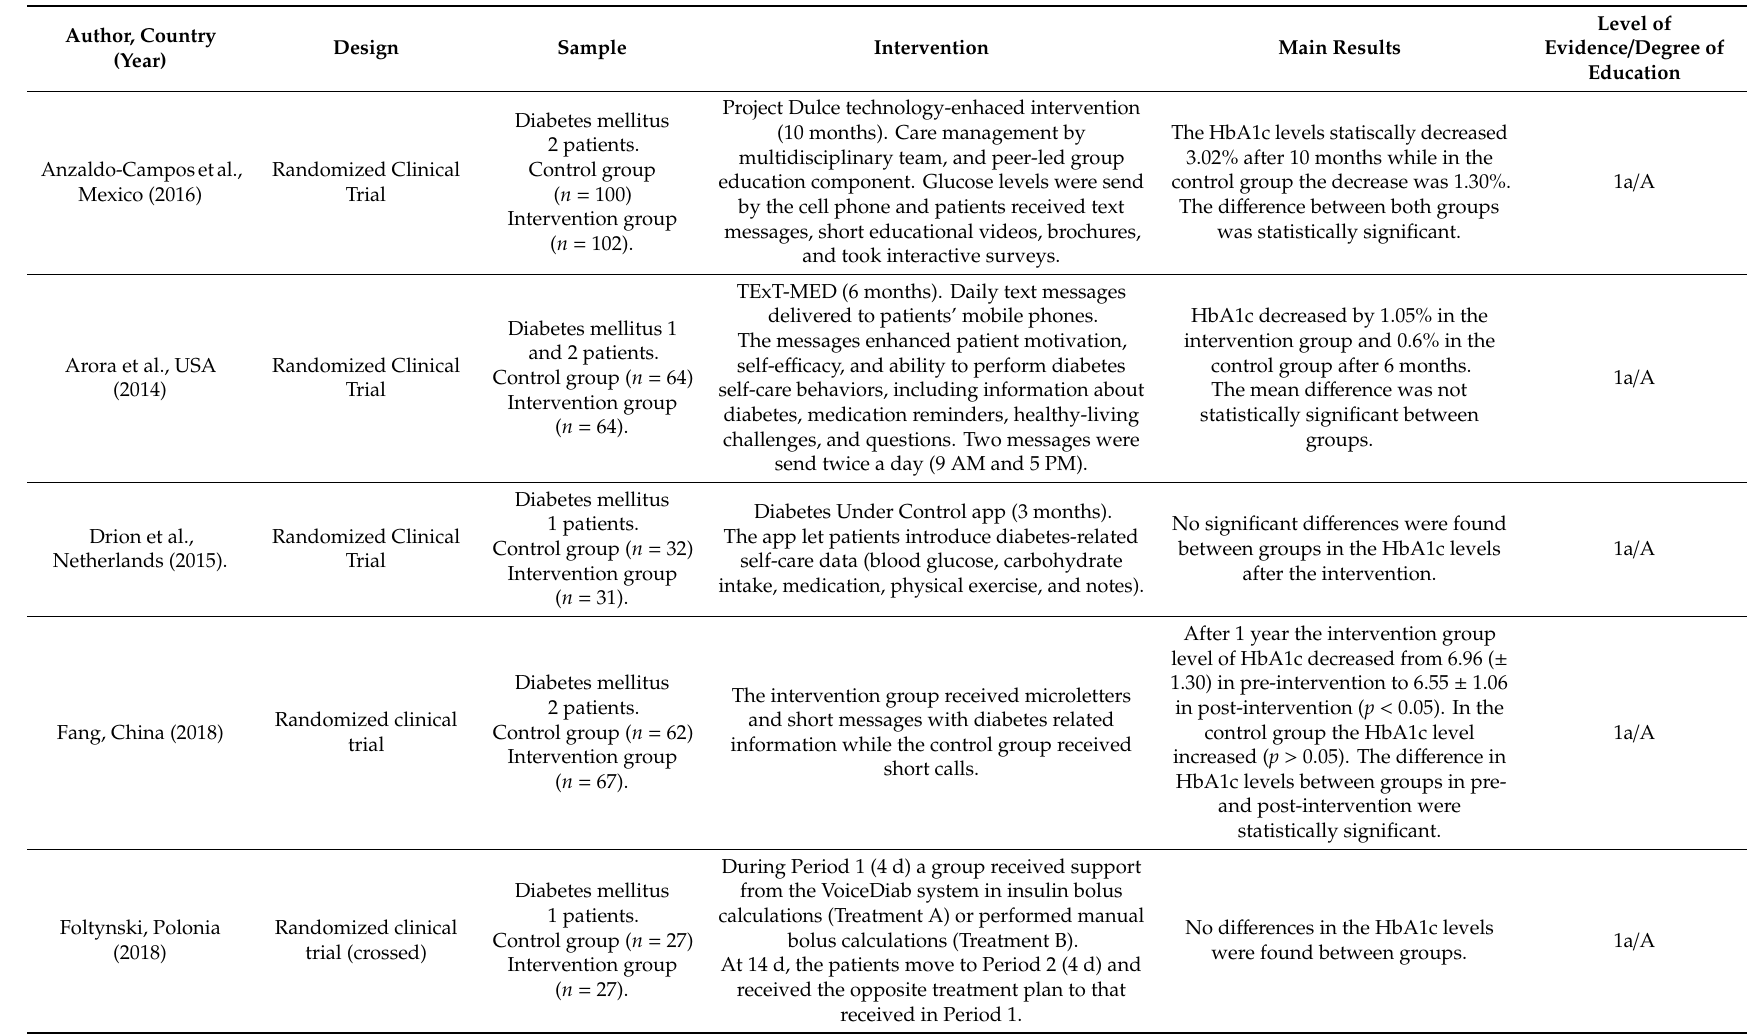
Table 1. Studies obtained from the